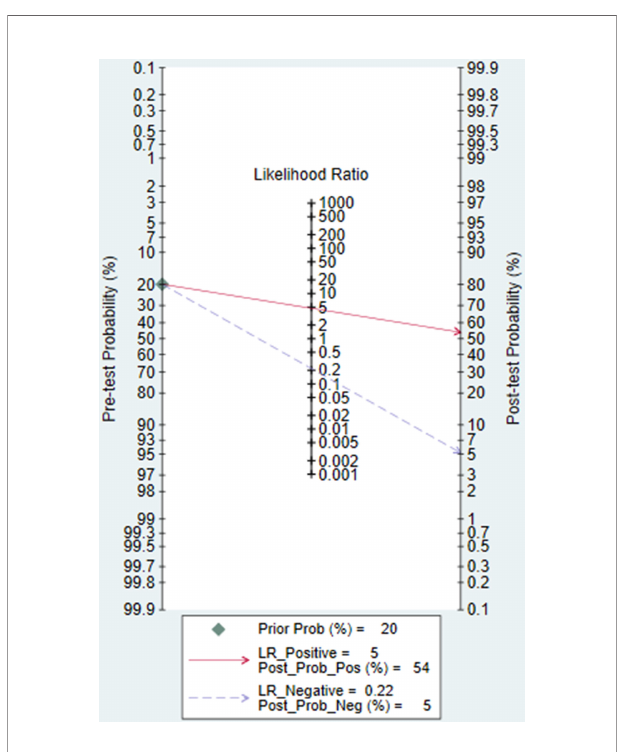
FIGURE 6 | Fagan plot of ML-based radiomics models of DCE-MRI in predicting ALNM in breast